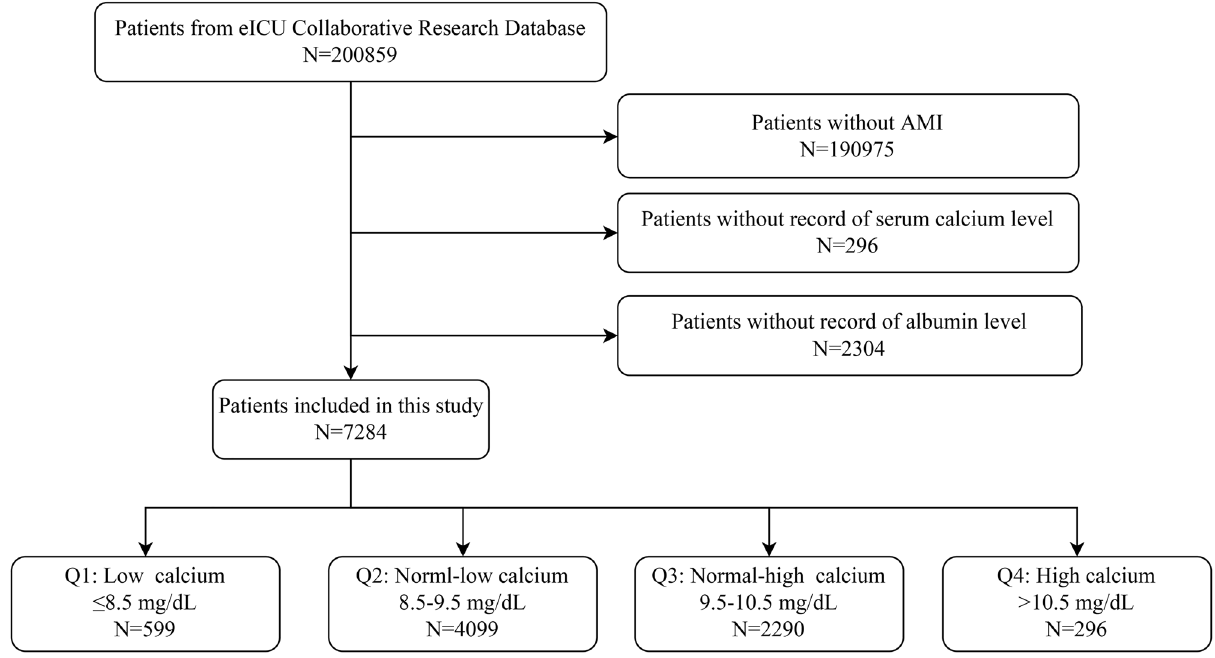
Figure 1. A flow chart of the inclusion and exclusion of